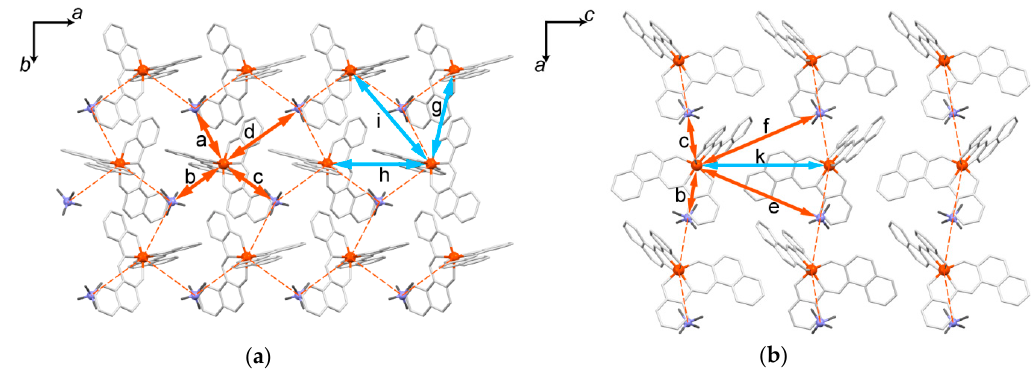
Figure 6. Crystal structure of 1 at 273 K. ( a ) Cation-anion arrangement parallel to the ab plane; and ( b ) cation-anion arrangement perpendicular to the ab plane. Acetonitrile molecules are omitted for clarity. Orange and cyan double arrows indicate neighboring Fe ¨¨¨ N and Fe ¨¨¨ Fe distances, respectively. Orange dash lines indicate neighboring Fe···N distances shorter than 6 Å. The letters correspond to those in Table 4. Table 4. The selected intermolecular distances in 1 , 2 , and 2’ . 1 T /K 90